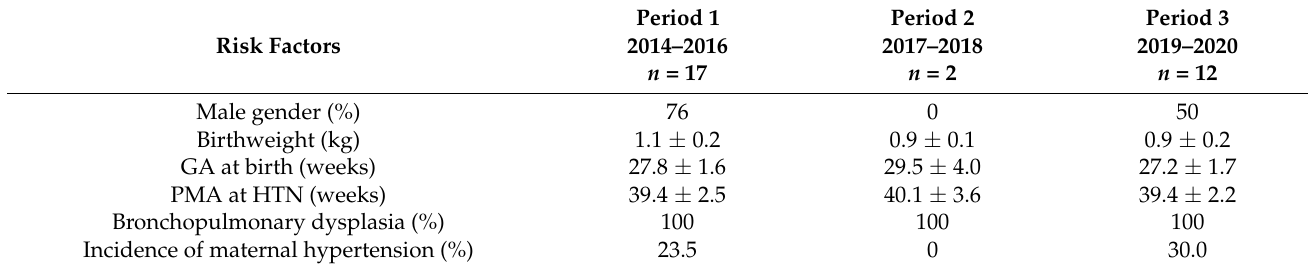
Table 3. Demographics and risk factors of neonatal hypertension in 31 VLBW infants with BPD over time.